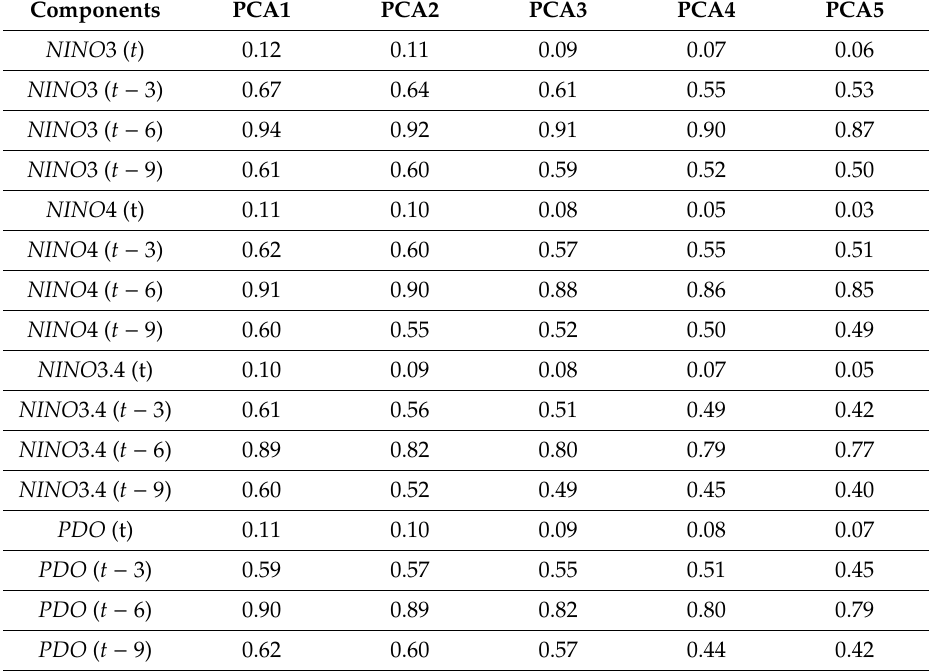
Table 3. Computed of coe ffi cient for determination of